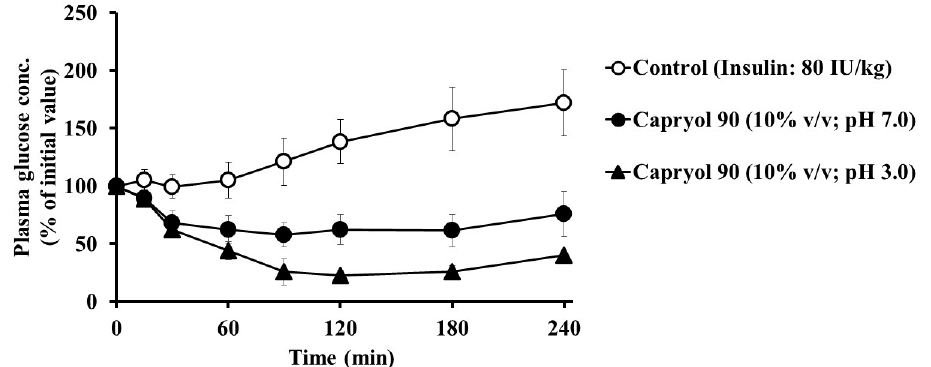
Figure 5. Effect of insulin solution pH on the intestinal absorption of insulin with Capryol 90. Each value represents the mean ± S.E. of three experiments.